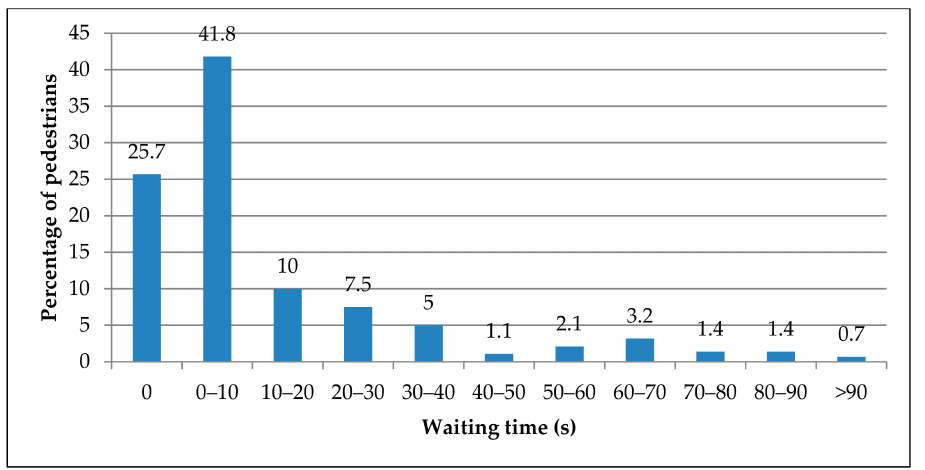
Figure 2. Waiting time of pedestrian at intersections.